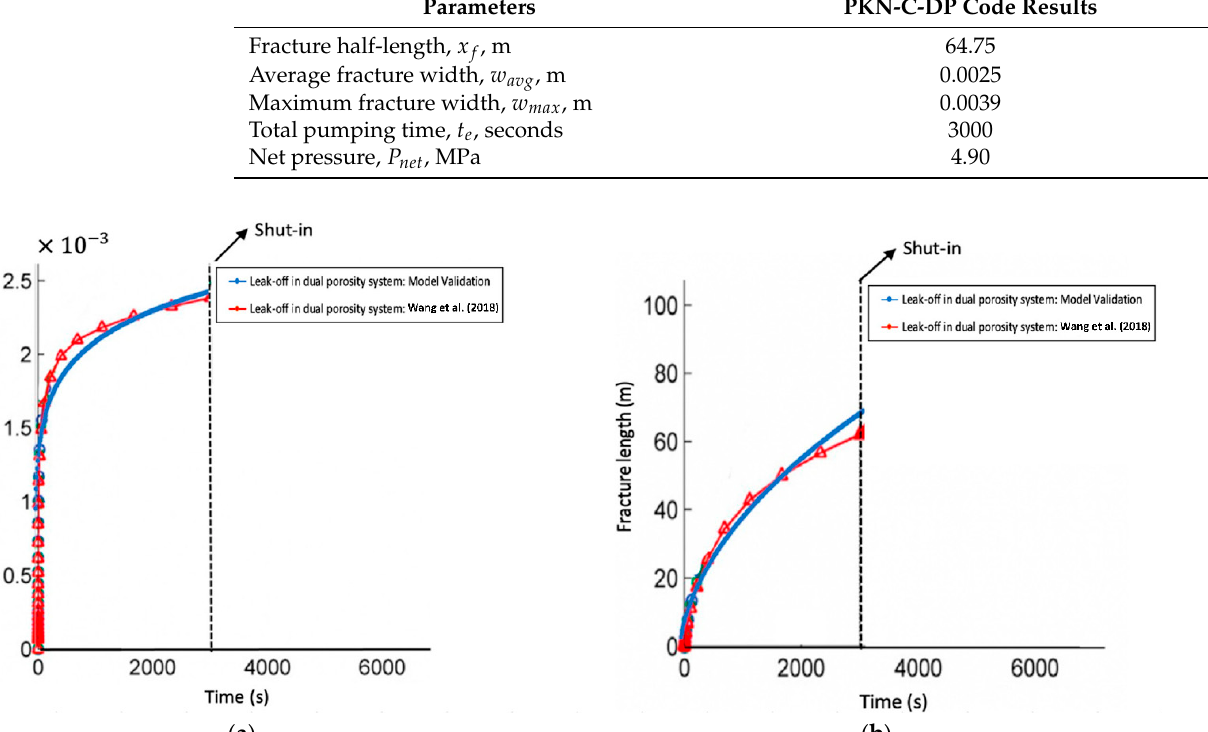
Figure 3. ( a ) Evolution of the average fracture width versus pumping time for leak-off into a dual-porosity system: Model validation versus Wang et al.’s [13] model; ( b ) Evolution of the fracture half-length versus pumping time for leak-off into a dual-porosity system: Model validation versus Wang et al.’s [13] model.